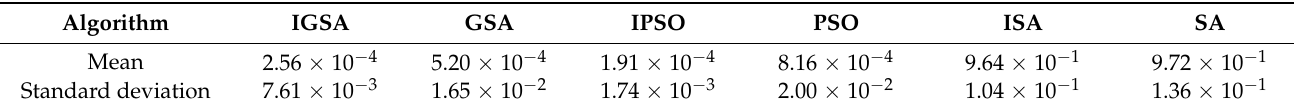
Table 4. The mean and standard deviation of the objective